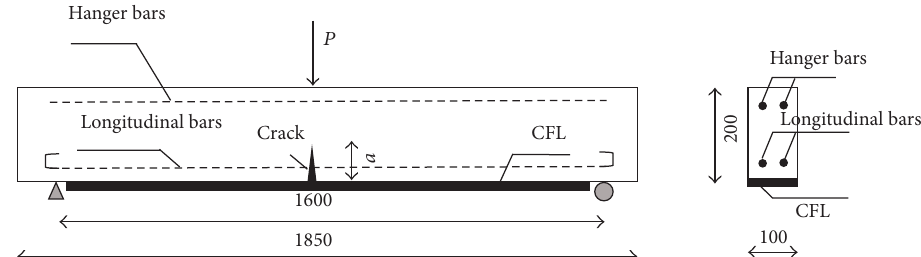
Figure 1: CFL-strengthened RC beam with a crack (unit: mm).